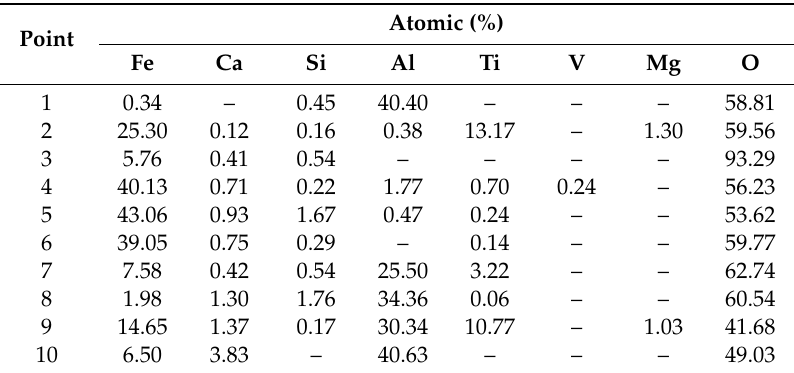
Figure 6. EDS point analyses of sintered Blend 2 with increasing temperature: ( a ) 1373 K; ( b ) 1423 K; ( c ) 1473 K; and ( d ) 1523 K. Table 5. EDS analysis for Blend 2 sintered at 1373 K .